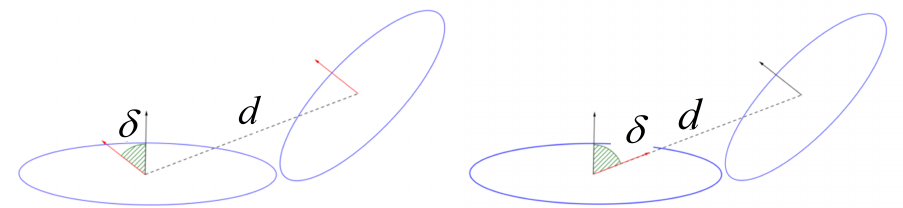
Figure 6. Computation of an d and δ between NDT(Normal Distribution Transform)-cell and base cell for matrix A ( right ) and matrix S ( left